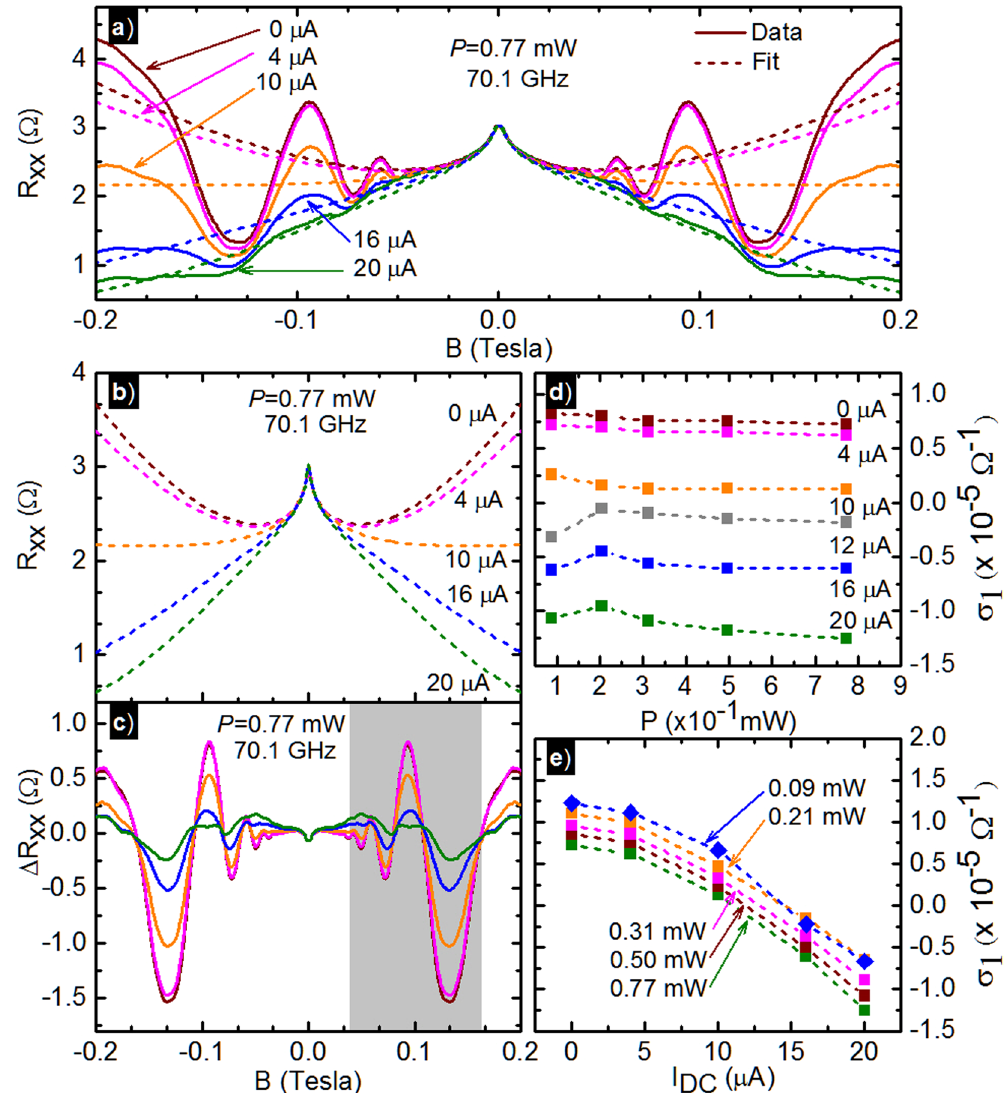
Figure 2. ( a ) Experimental data of Fig. 1(b) with model fits of the non-oscillatory giant magnetoresistance in the GaAs/AlGaAs 2DES using the multi-conduction model described in the text. ( b ) Fit extracted non- oscillatory R xx of panel (a) at various dc-current, I dc at P = 0.77 mW . ( c ) This panel exhibits the extracted radiation-induced magnetoresistance oscillations after subtracting the model fits from the experimental data of panel (a), at various I dc at P = 0.77 mW . The highlighted region was used for the fits shown in Figs 3(a) and 4(a). ( d ) Model extracted conductivity σ 1 vs. P , at various I dc . ( e ) Shows σ 1 vs. I dc at different P , the traces are offset vertically by × Ω − − 1 10 6 1 for clarity. Dashed lines in ( d , e ) are guides to the